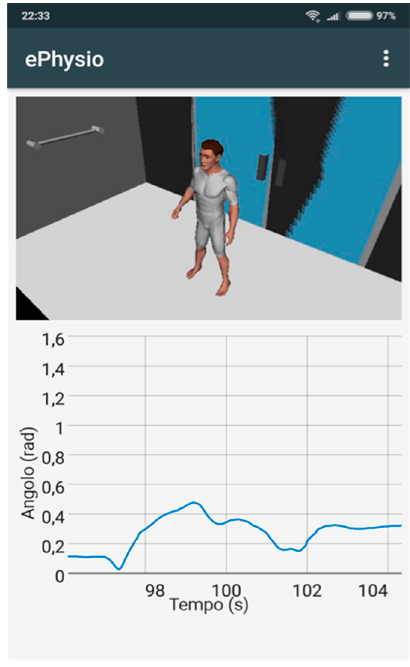
Figure 8. Android application layout.